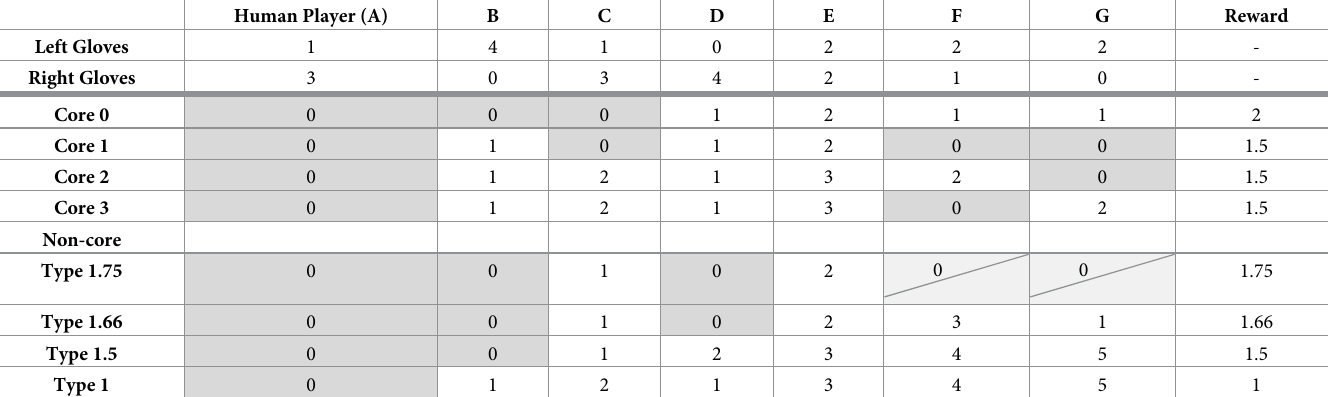
Table 6. Final coalition structures for the game with multiple core partitions (note that for type 1.75, either player F or G was included in the human players’